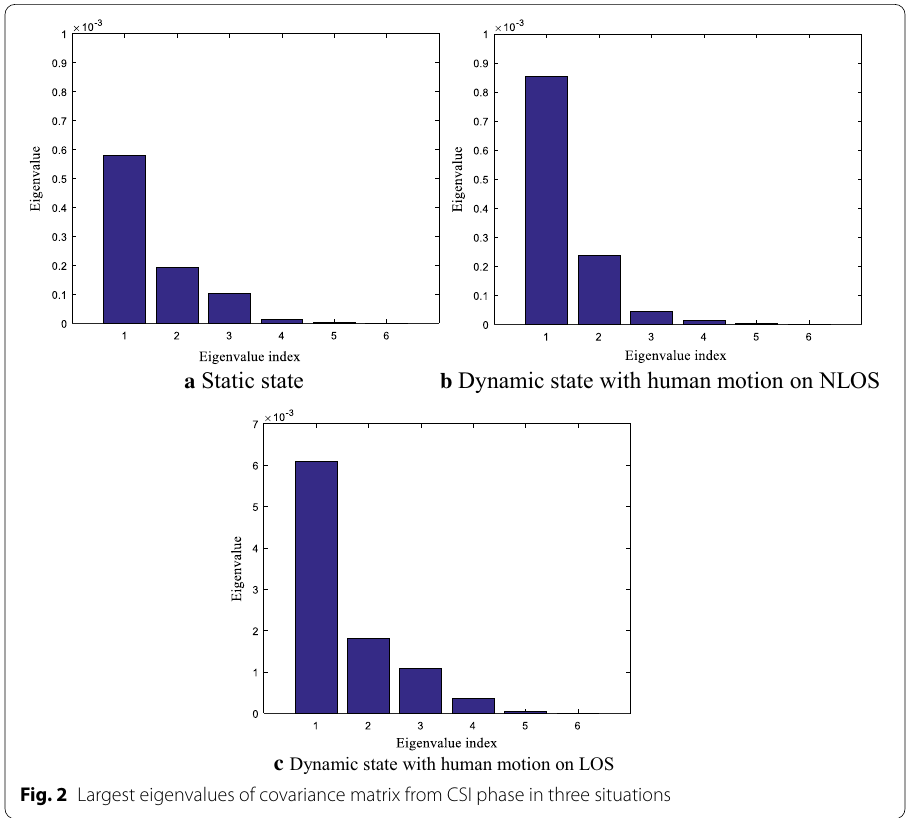
Fig. 2 Largest eigenvalues of covariance matrix from CSI phase in three